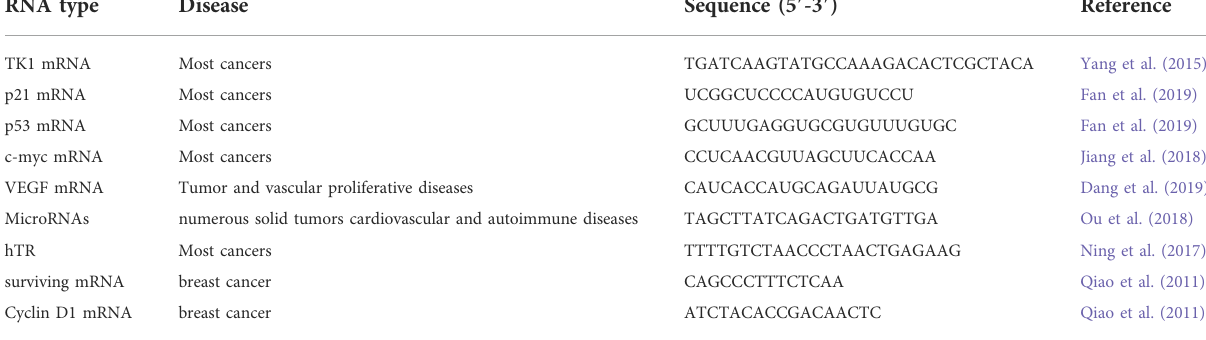
TABLE 1 The relationship between RNA type and